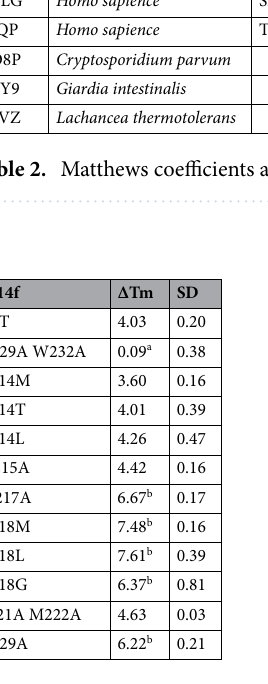
Table 3. The difference in the melting temperature of St14f between free and complex with StFDL1 peptide measured by thermal shift assay. a No direct interaction with the StFDL1 peptide. b Stabilized the complex with the StFDL1 peptide by